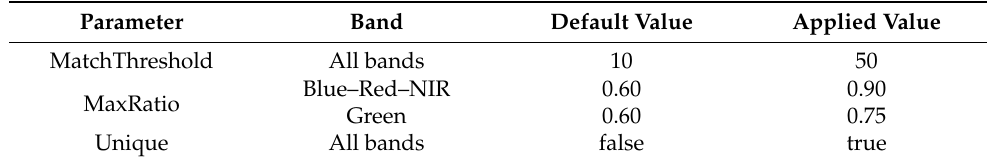
Table 3. Default and applied values of the parameters of the matchFeatures function used to register the MicaSense ® RedEdge